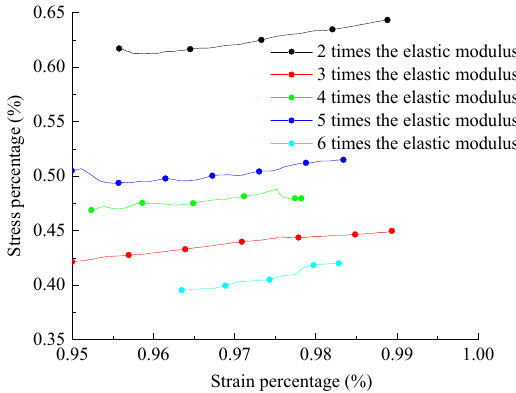
Figure 10. The axial stress of abnormal area in AE quiet period.